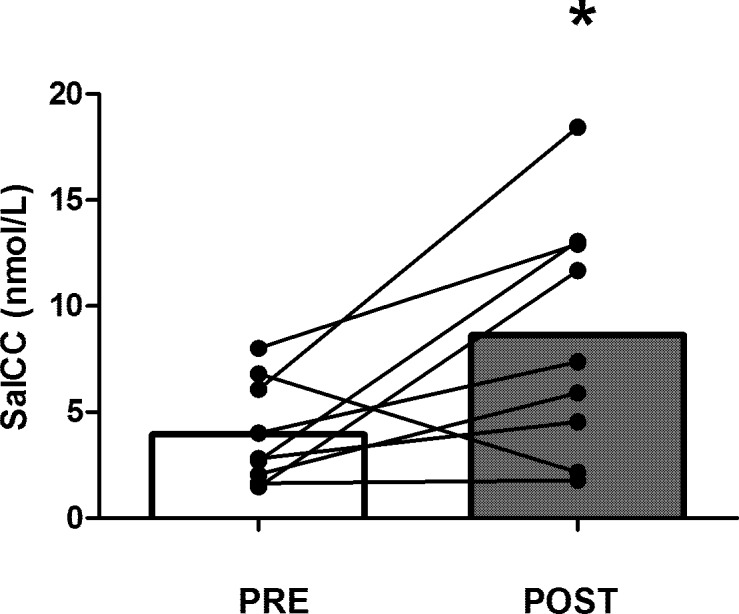
Salivary cortisol concentration (SalCC) 10 minutes before (PRE) and 10 minutes after (POST) a singles tennis match.Bars are means. Individual responses are displayed as dots linked with lines. * Denotes difference between PRE and POST measurements (P = 0.033).